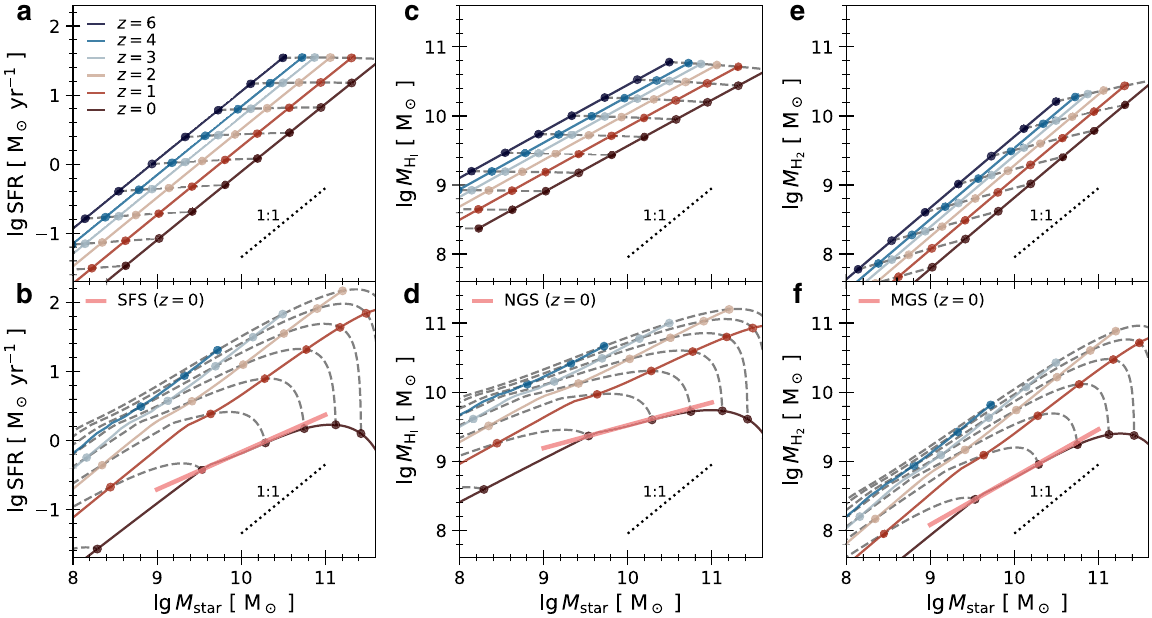
Fig. 6 Redshift evolution of galaxy scaling relations. The star-forming sequence (SFS, a , b ), neutral gas sequence (NGS, c , d ), and molecular gas sequence (MGS, e , f ) and their redshift evolutions as predicted by two simple analytic models that link star formation rates (SFRs) and gas masses ( M gas ) of galaxies / M 0 : 28 via SFR ¼ M gas f H2 = t dep ; H and t dep ; H SFR (cid:2) 0 : 24 . In both models, the stellar mass ( M star ) is the integral of the SFR, i.e., stellar mass loss and mergers star 2 2 are ignored. Furthermore, the molecular-to-total gas mass ratio ( f H2 ) is assumed to depend only on stellar mass with f H2 ( M star ) given by the scalings of the molecular and neutral gas sequences. In each panel, solid lines connect galaxy populations at a fi xed redshift ( z = 6 – 0 from top to bottom), while dashed lines show the time evolution of individual galaxies. Linear slopes are indicated by dotted lines. a , c , e Predictions of an equilibrium model in which M gas does not change with time. The SFS has a slope of 1, while the slope of the MGS (NGS) is slightly steeper (less steep) than linear. b , d , f Predictions of a model with a time-dependent M gas such that M gas peaks at earlier times in more massive galaxies ('downsizing'). This second model is successful in reproducing the sub-linear slopes of the SFS, MGS, and NGS (thick straight lines). Furthermore, it predicts that the slope of the SFS becomes steeper and more linear at higher redshift in qualitative agreement with observations 38,48,49